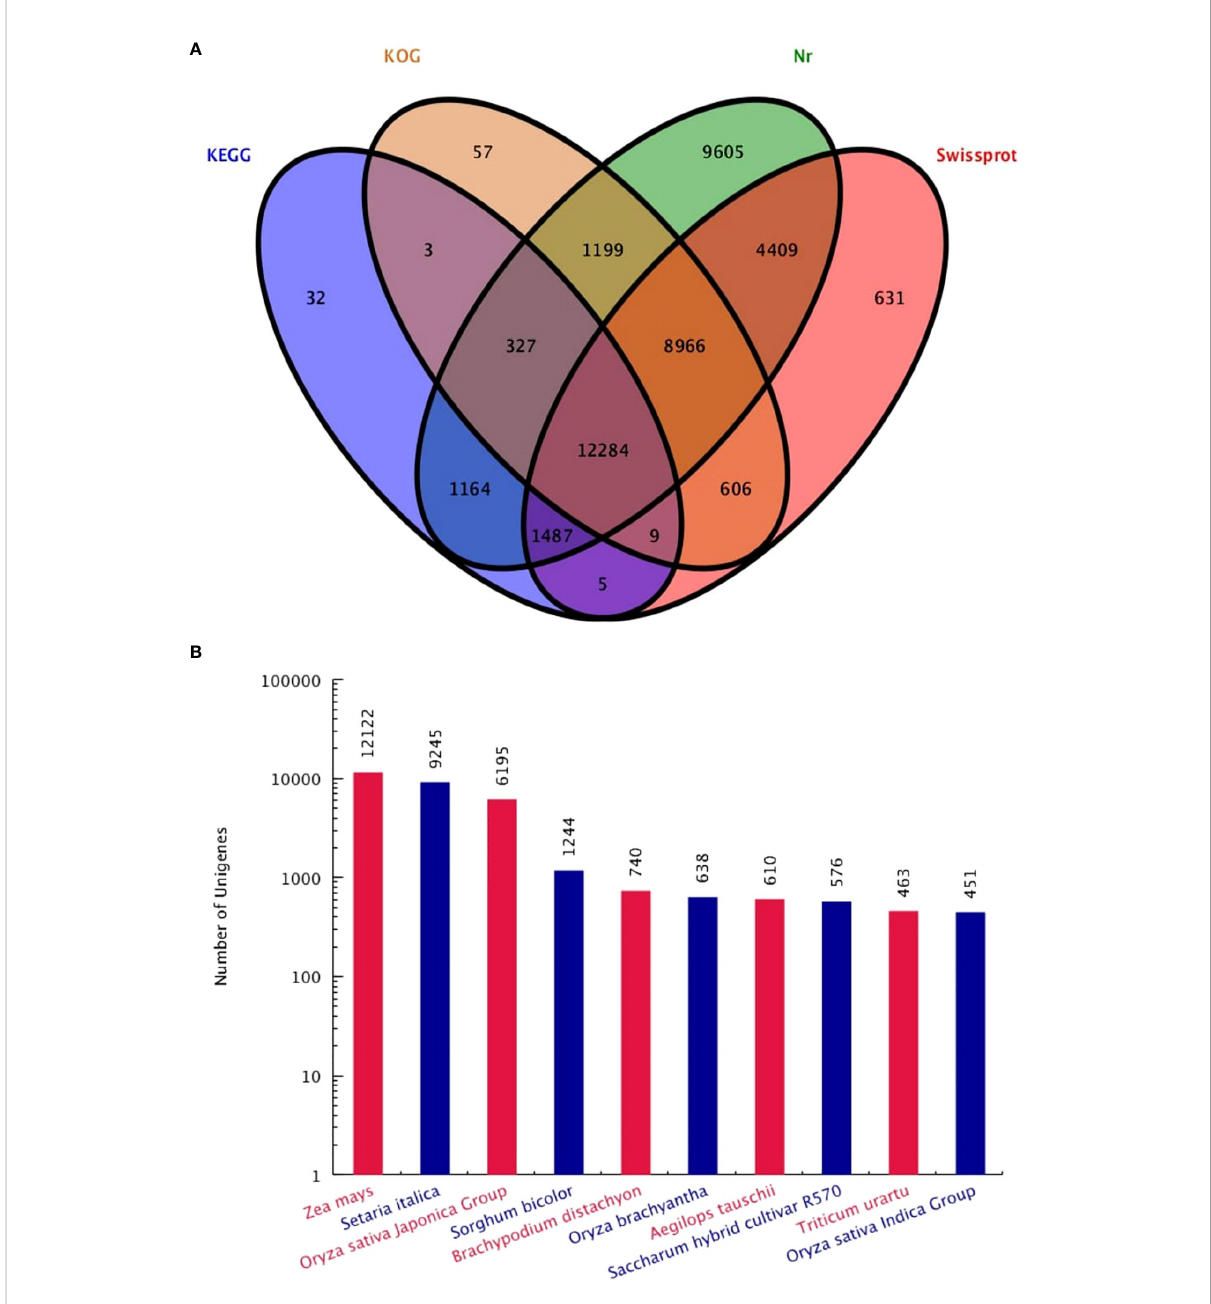
FIGURE 2 Venn diagram (A) of four major database annotations and statistical map of species distribution (B) of the fi rst ten species are